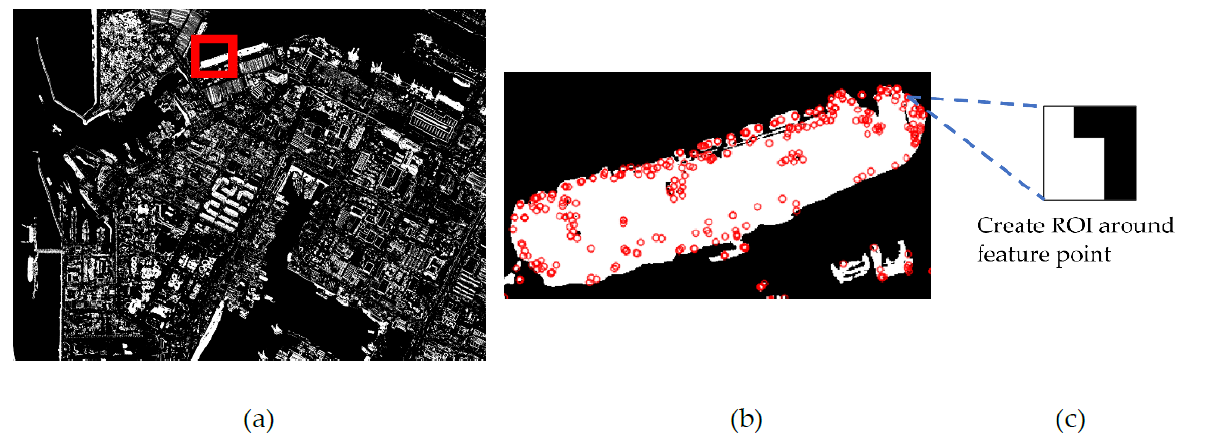
Figure 3. The process of feature-based change analysis: ( a ) a pixel-based change map; ( b ) the distribution of features within the marked area of the pixel-based change map; and ( c ) one ROI of 3 × 3 pixels defined on a feature point.